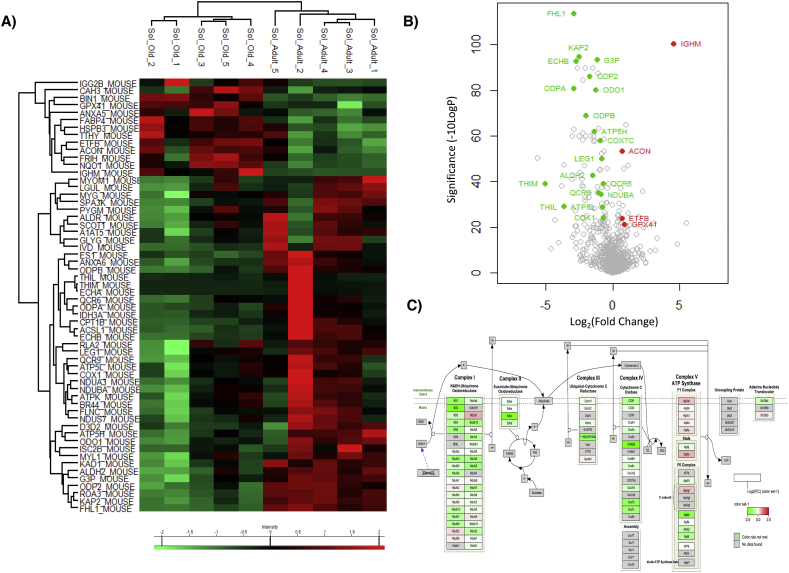
Label free proteomics soleus from adult and old mice, (A) Heatmap of significantly changed proteins with fold change >1.5 and –10logP > 20 equivalent to P < 0.01 (B) Volcano plot of quantified protein changes with age and significance, proteins highlighted in red are significantly increased with age and proteins highlighted in green are decreased with age. Proteins highlighted in blue were antioxidant proteins that did not significantly change in abundance and were selected for immunoblotting. (C) Pathway analysis of quantitative proteomic data using PathVisio reveals a downregulation of proteins involved in mitochondrial electron transport chain.